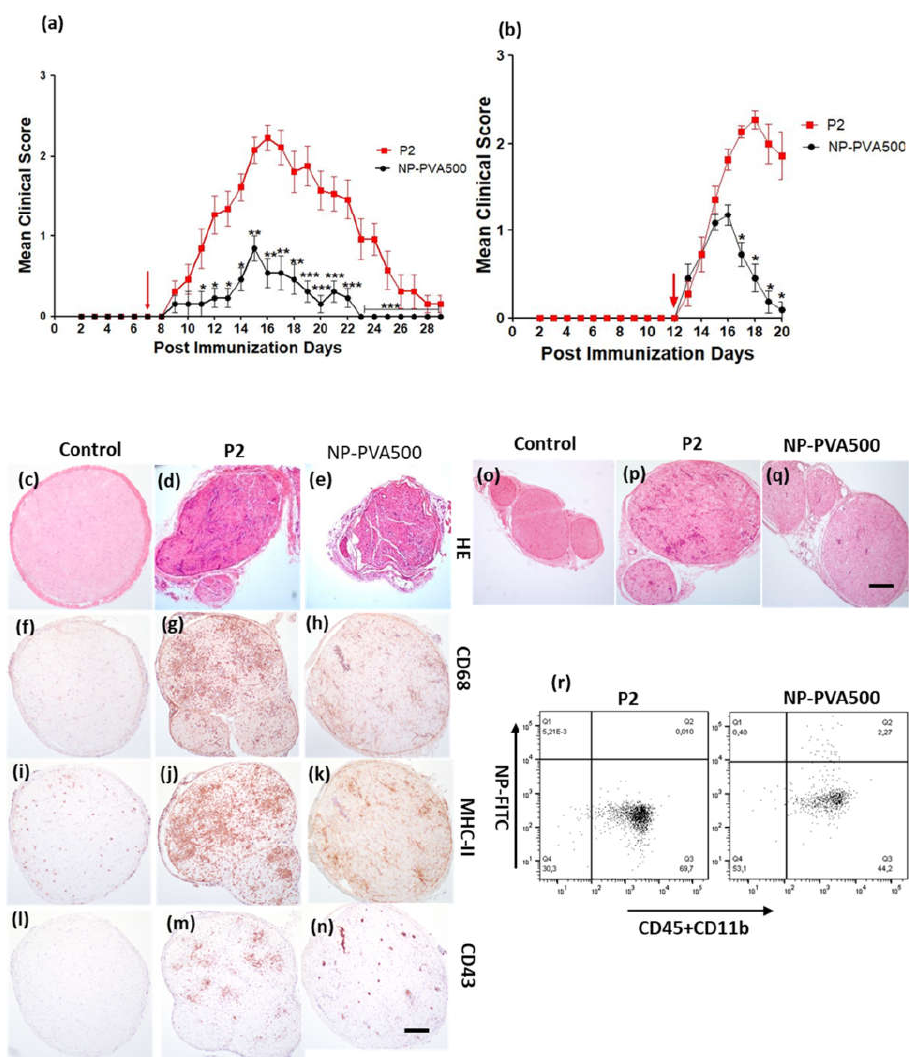
Figure 1. Treatment with NP-PVA500 before and at early onset of EAN symptoms. ( a ) Mean clinical score (± S.E.M.) post-immunization with P2-peptide and NPs. The P2-peptide ( n = 13) group was administered with P2-peptide only. The NP-PVA-500 ( n = 13) group, in addition with P2-peptide, was administered with a daily intravenous 9 mg/kg dose of NP-PVA500 before the onset of EAN. ( d , e ) Histological changes in the sciatic nerves of P2-peptide and NP-PVA-500 treated animals and co-localization of infiltrates with routine H&E histology A high titer of activated macrophages (CD68) was observed in the P2-peptide group ( g ) in contrast to a smaller proportion of macrophages found in the NP-PVA500 group ( h ), while in the control animals ( f ) no such response was observed. A clear difference in MHC-II (OX-6) positive cell population between the P2-peptide group and the -NP-PVA500 group was observed ( j , k ). A considerable accumulation of T-cells (CD43+) was observed in P2 animals ( m ) at the end of the experimental phase, while a lesser population of T-cells was observed in the NP-PVA500 group ( n ) at the same time. Treatment with NP-PVA500 at the early onset of EAN: ( b ) Mean clinical scores ( ± S.E.M.) of P2-peptide ( n = 11) group and NP-PVA500 treated group ( n = 11). Early-onset treatment with a 9 mg/kg dose of NP-PVA500reduced the perivascular infiltration of mononuclear cells ( q ). A high titer of accumulation of infiltrating monocytes across the perivascular region of the sciatic nerves was observed in P2-Peptide treated rats ( p ). The control group didn’t exhibit any histological changes ( c , f , i , l , o ). (The arrow indicates the start of NPs treatments.) ( r ) Dot plots of the flow cytometric representation of the percentage of the extent of NP-FITC+ monocytes (blood). Magnification 10x. Scale bar represents 50 µ m. Mann-Whitney nonparametric U -test. * p ≤ 0.05, ** p ≤ 0.01, *** p ≤